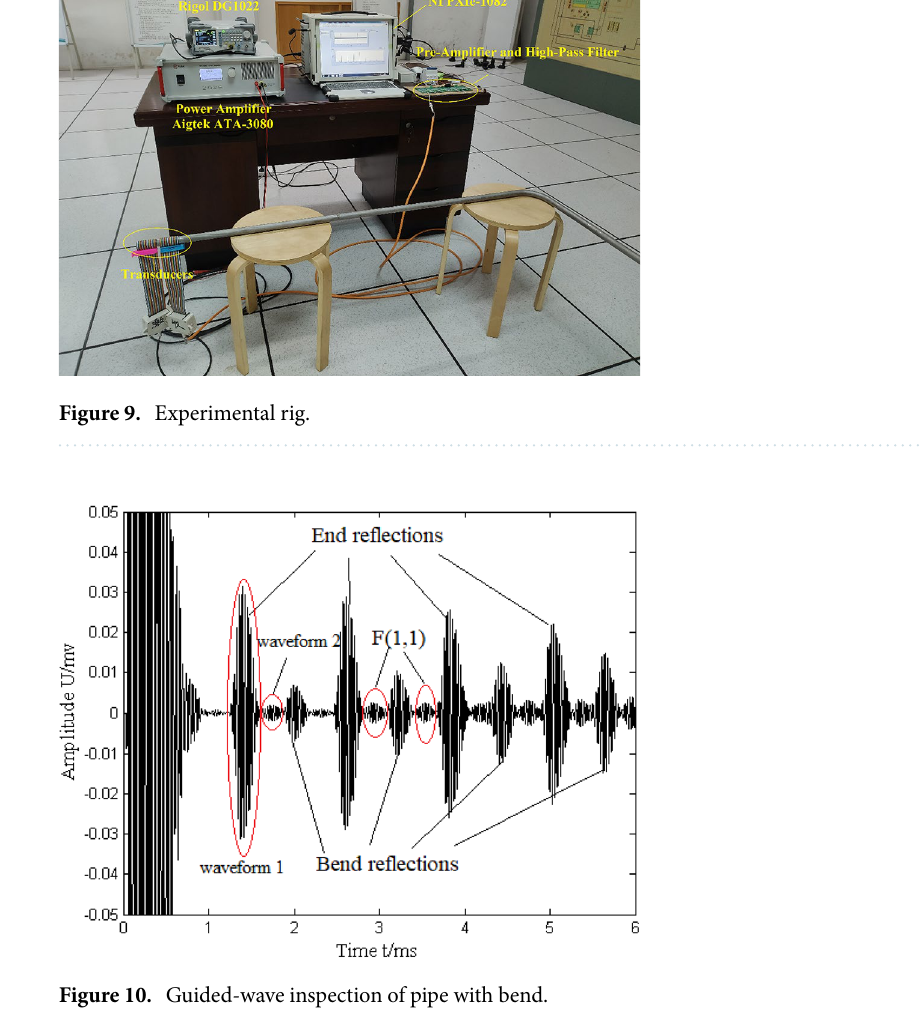
Figure 10. Guided-wave inspection of pipe with